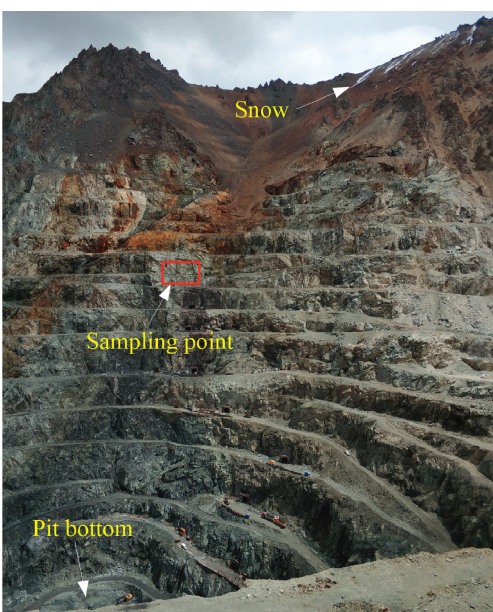
Figure 1: Rock samples were collected from the eastern slope of Beizhan Iron